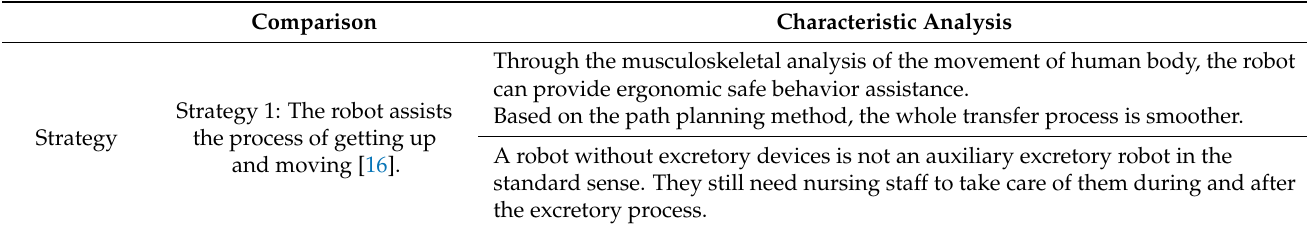
Figure 15. The simulation and experiment of auxiliary excretion transfer.( a ) Simulation of auxiliary Figure 15. Simulation and experiment of auxiliary excretion transfer : ( a ) Simulation of auxiliary 515 transfer. ( b ) Simulation of auxiliary transfer after position adjustment. ( c ) Transfer experiment and its transfer; ( b ) Simulation of auxiliary transfer after position adjustment; ( c ) Transfer experiment and 516 its transfer point; ( d ) Transfer experiment and the adjustment of the transfer point. transfer point. ( d ) Transfer experiment and the adjustment of the transfer point. Table 1. A comparison between the proposed method and the traditional